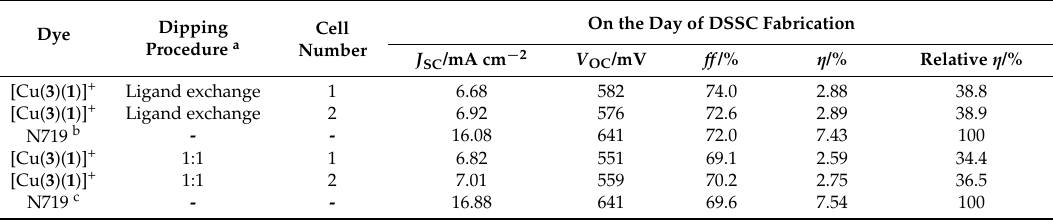
Table 2. Performance parameters (under 1 sun illumination) of duplicate, masked DSSCs with [Cu( 3 )( 1 )] + on the day of sealing the cells. The data are compared to a DSSC containing N719 and relative η values are with respect to N719 set at 100%. Data are from ref.